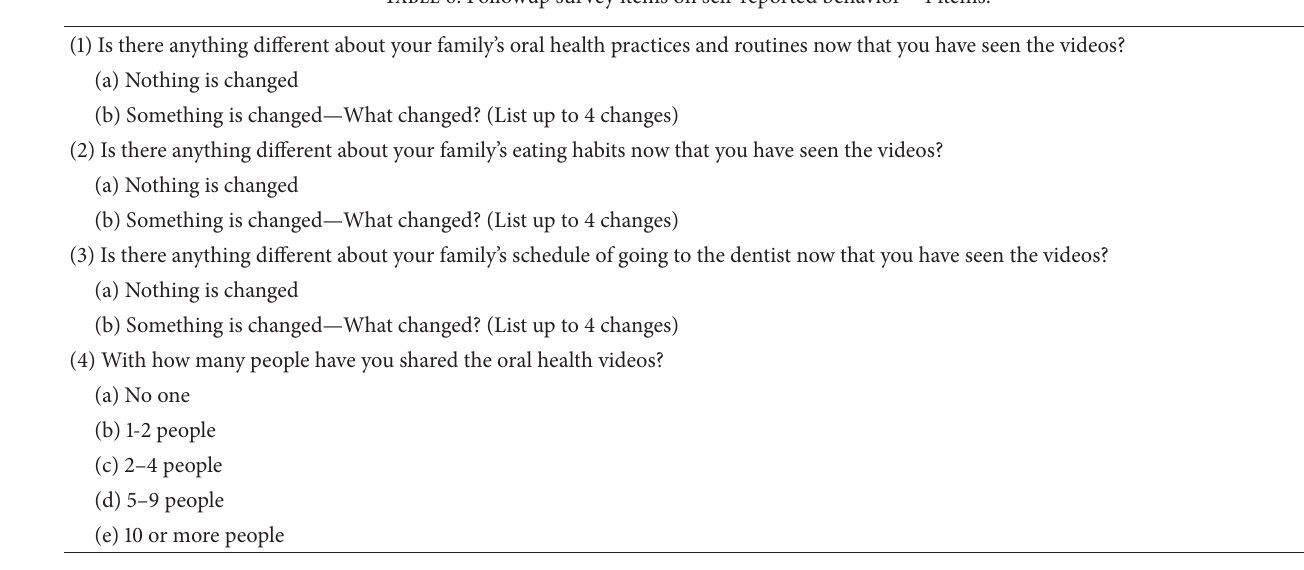
Table 6: Followup survey items on self-reported behavior—4